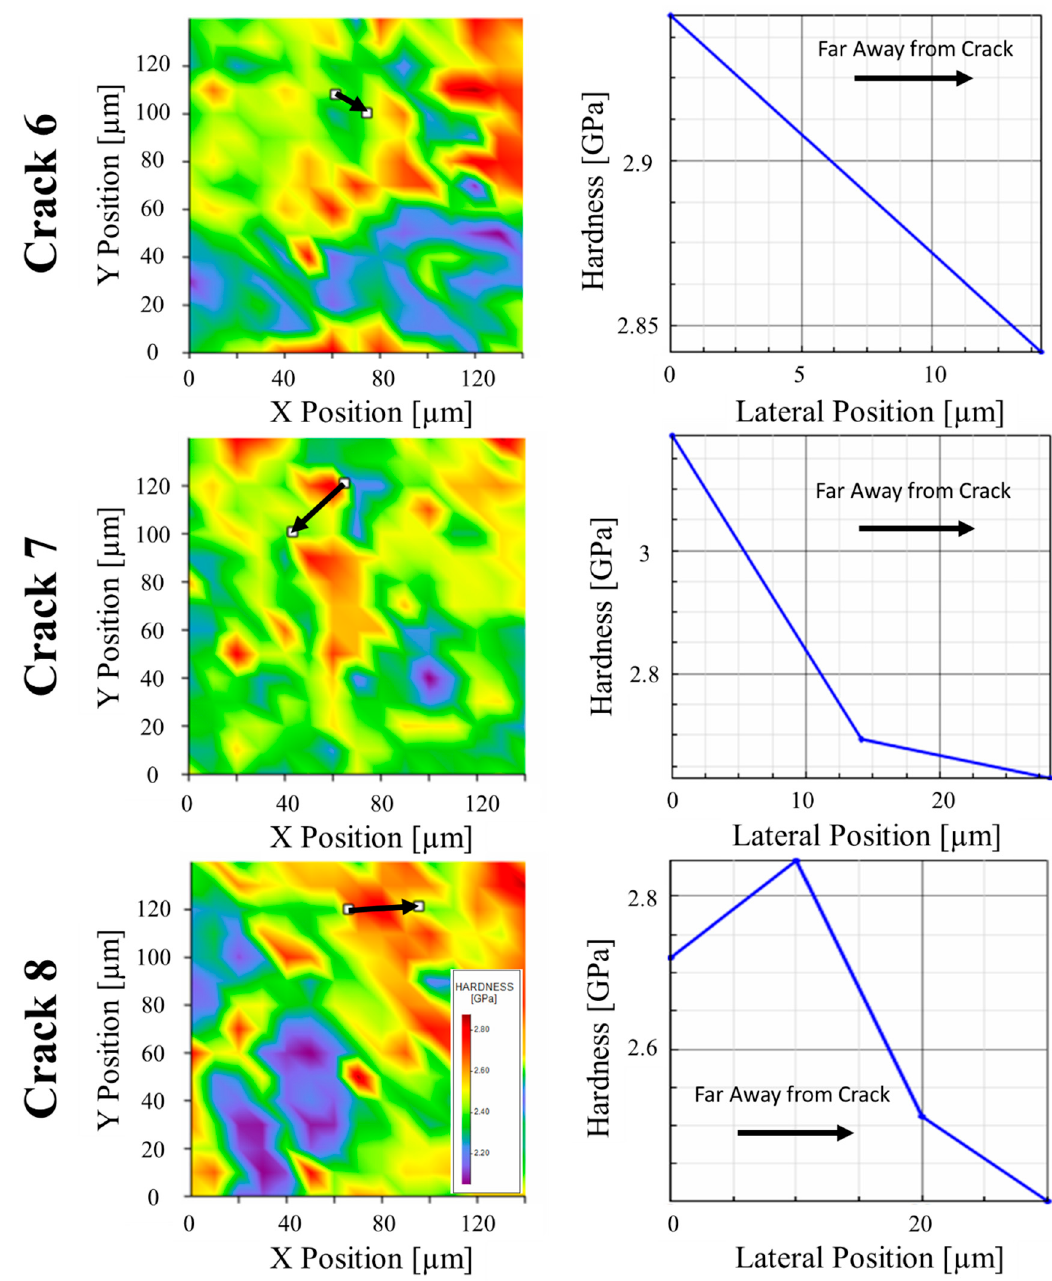
Figure 9. NanoBlitz maps with corresponding intragranular line scan hardness profile along the arrowed path from the crack to the GB within a cracked grain for cracks #6–#8.